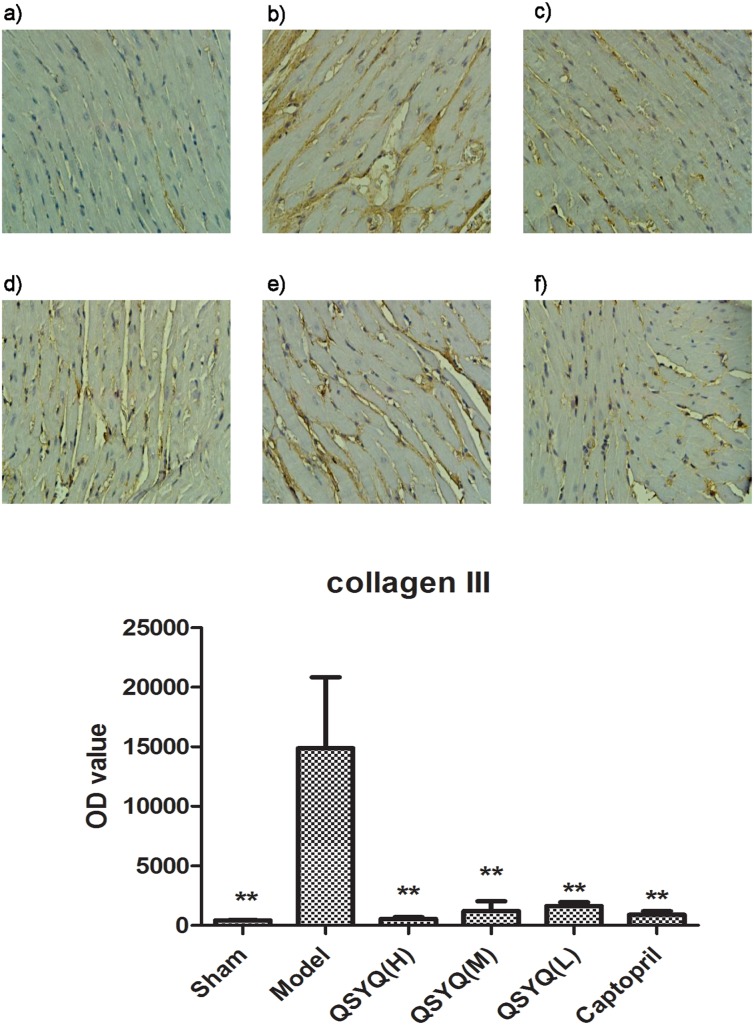
Results of Collagen III expression in different groups.The concentrations of collagens III in the model group (b) were obviously higher than those in sham group (a). Whereas the levels of collagens III in high QSYQ (c), middle QSYQ (d) and low QSYQ groups (e) were remarkably lower than that in the model group. There is a dosage-dependent manner. Captopril group (f) showed a same effect as QSYQ. Quantitative analysis of collegen III was presented in (g). n = 10∼14 for each group. OD values represent the mean ± SD. *P<0.05 vsModel group, **P<0.01 vs Model group.